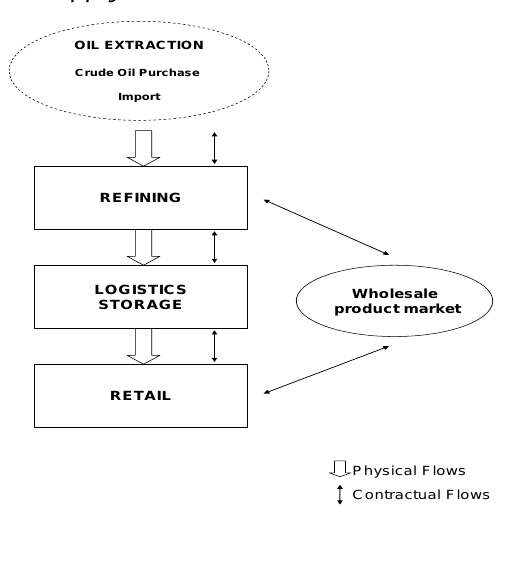
Figure 2: Motor Fuel Supply Chain